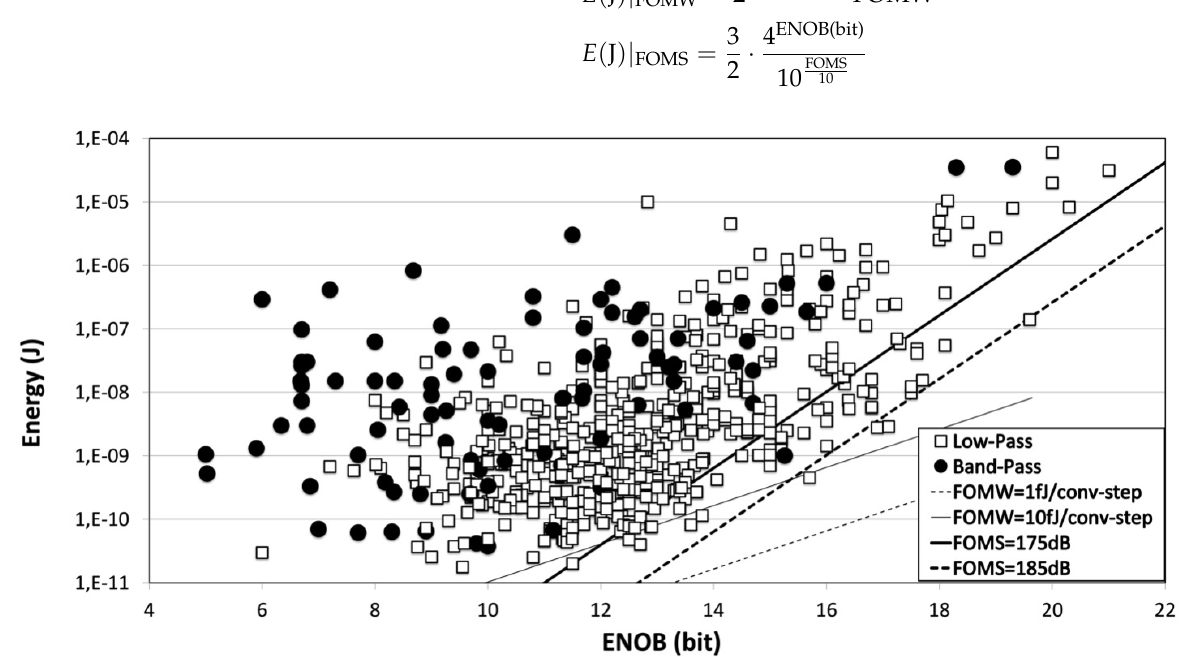
Figure 13. Energy plot of Σ∆ Ms: BP- Σ∆ Ms vs. LP- Σ∆